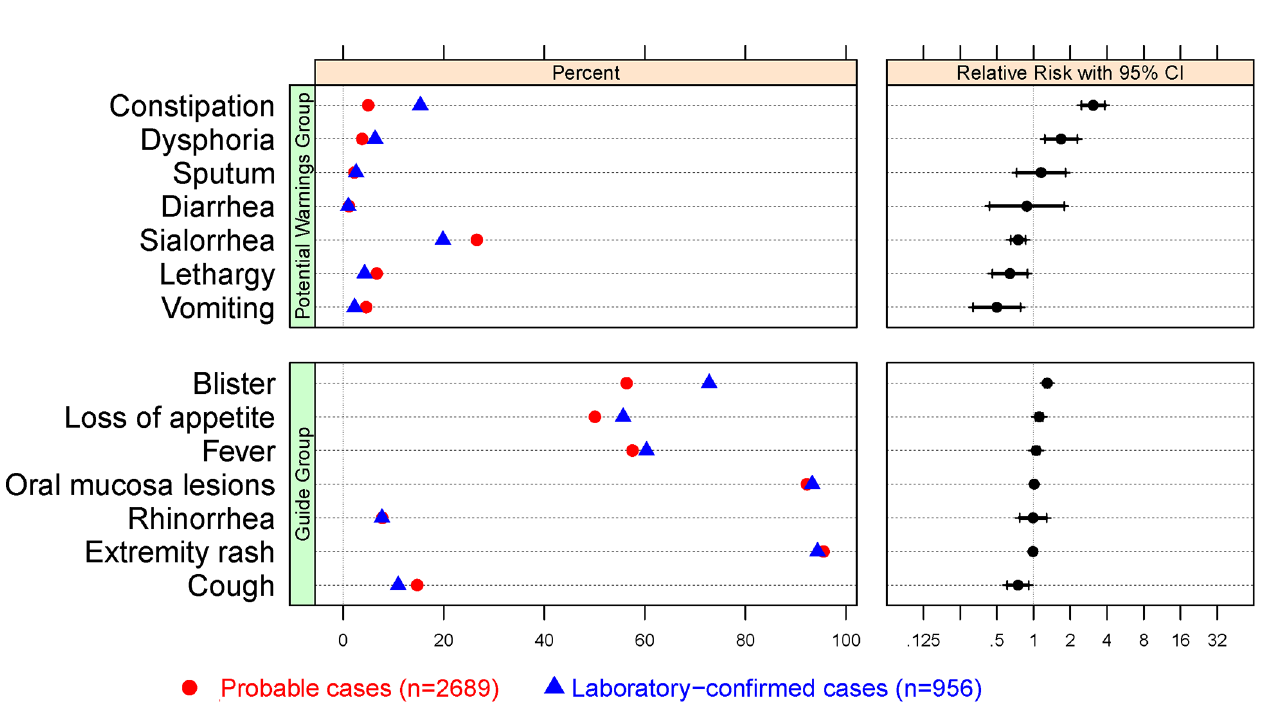
Fig 4. Most Frequent On Symptoms and Signs Sorted by Relative Risk. The first panel displays the percent of symptoms and signs, with different symbols for each group. The second panel displays the relative risk of a symptom on the laboratory-confirmed cases relative to the probable cases, with 95% confidence intervals for a 2 × 2 table.